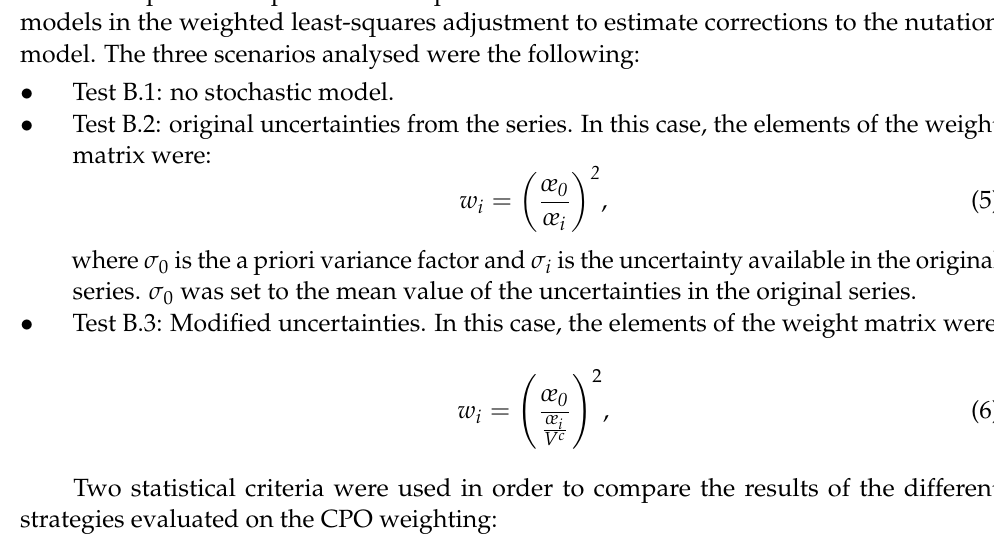
Figure 3. Relationship between the CPO precision and the VLBI network volume.